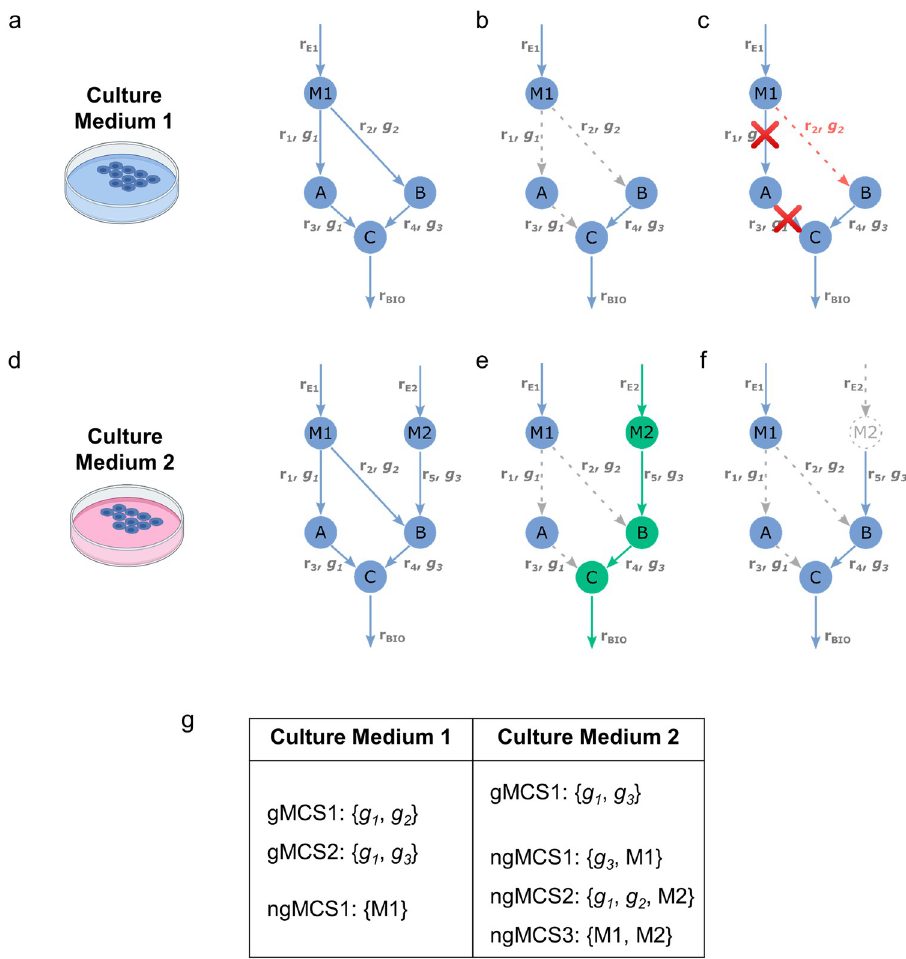
Fig 1. Synthetic Lethality in 2 different environmental contexts. (a) Example metabolic network under Culture Medium 1 (CM1). We have 5 reactions (r E1, r 1 , r 2 , r 3 , r 4 ), 4 metabolites (M1, A, B, C) and 3 genes (g 1 , g 2 , g 3 ). r E1 is an input exchange reaction and represents the availability of M1; (b) g and g are synthetic lethals under CM1. (c) If g is 1 2 2 not active (red dotted line), the inhibition of g 1 is essential under CM1. (d) Example metabolic network under Culture Medium 2 (CM2). With respect to the metabolic network in (a), we have 2 additional reactions (r E2, r 5 ) and 1 additional metabolite (M2). r E2 is an input exchange reaction and represents the availability of M2; (e) g1 and g2 are not synthetic lethal under CM2 due to the alternative pathway via M2 degradation (in green). (f) The inhibition of g1 and g2 and deprivation of M2 in the metabolic network from (d) renders cellular proliferation impossible. (g) gMCSs and ngMCSs for CM1 and CM2. Gray dotted lines stand for not active/not present